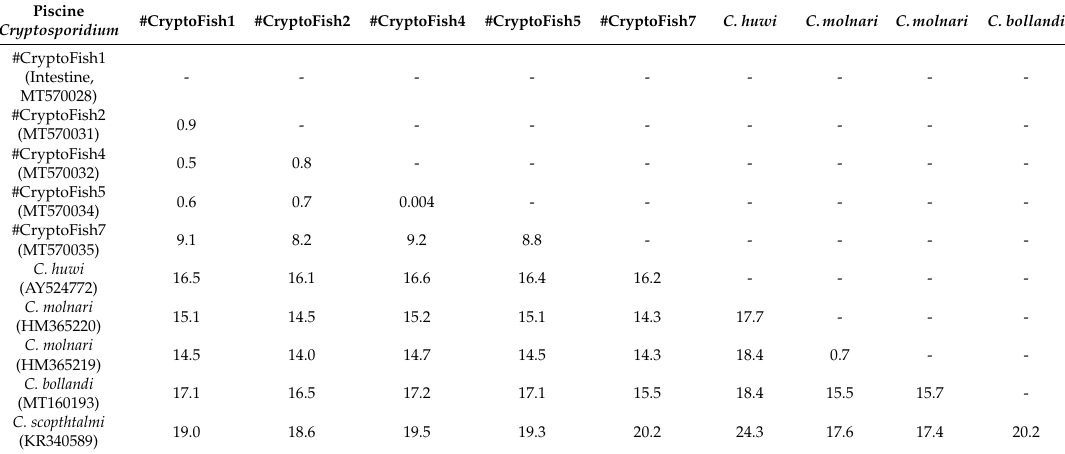
Table 2. Pairwise genetic distances (%) between the piscine Cryptosporidium spp. and genotypes found in the present study at the actin locus based on 722 bp sequences.